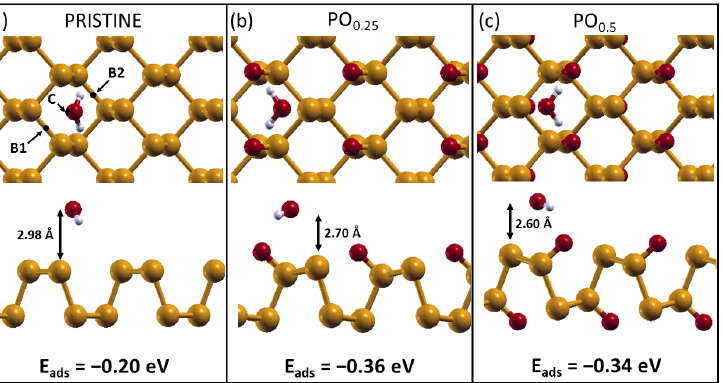
Figure 3. Top ( upper panel ) and lateral ( lower panel ) view of the optimal configurations for water adsorption on the three phosphorene substrates: pristine phosphorene ( a ) and oxidized phosphorene with an oxygen coverage of, respectively, 25% ( b ) and 50% ( c ). The three adsorption sites tested are represented as well: short bridge (B1), center (C), and long bridge (B2). The relevant lengths are reported, together with the three adsorption